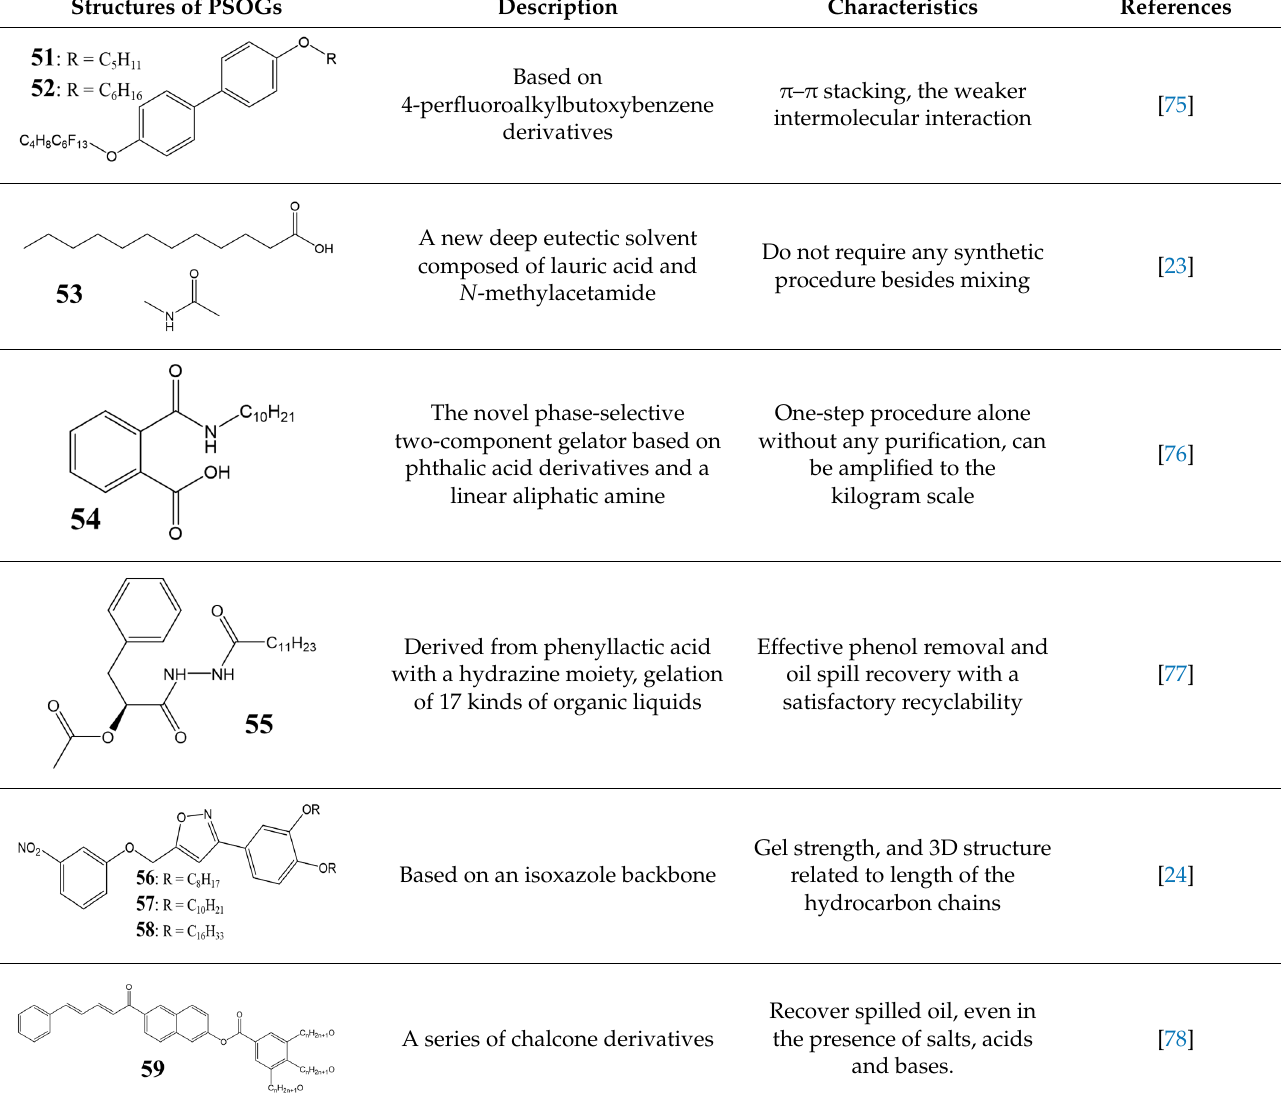
Table 1. Other types of PSOGs 51 – 59 with their structures and characteristics. Structures of PSOGs